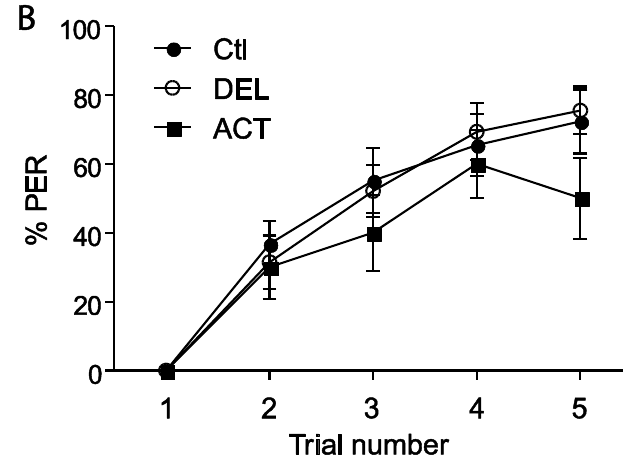
Figure 4. PER responsiveness of honey bee when drugs were applied during learning sessions. ( A , B ) bees treated with 10 ng/bee or 100 ng/bee of ACT or DEL, respectively. The learning performance is expressed as the percentage of PER to antennal stimulation with 40% sucrose solution. Each group represents n = 90 bees. Bars represent standard